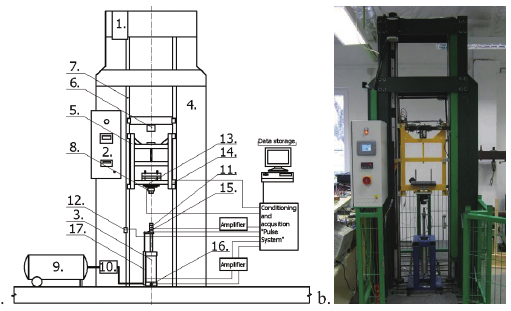
Fig. 2. Considered mechanical system: a. numerical model; b. experimental